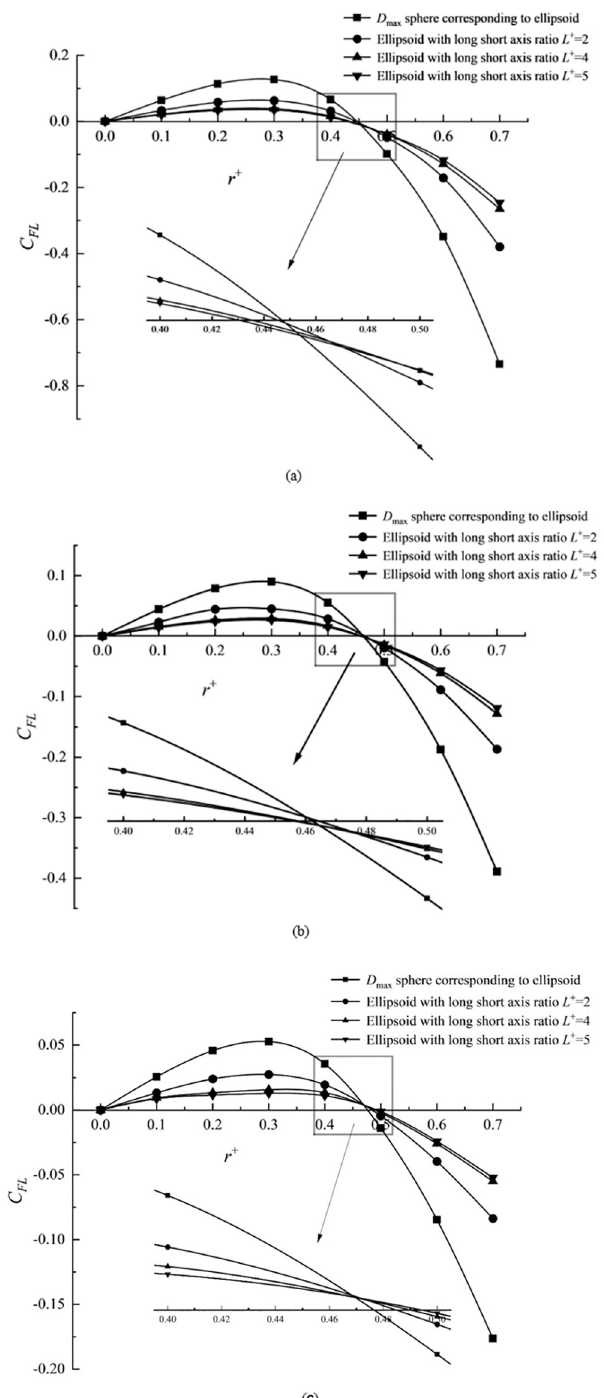
Fig 7. Lift distribution of elliptical particles and its corresponding circular particles under different relative size and long short axis ratio. (a) a + = 0.2, (b) a + = 0.15 and (c) a + = 0.1.